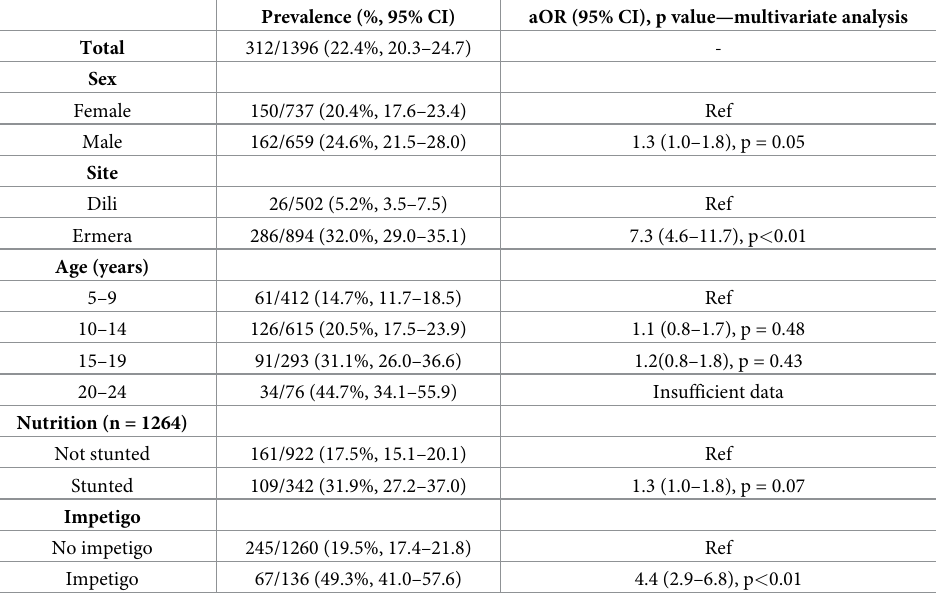
Table 2. Prevalence of scabies and adjusted odds ratio for variables in multivariate analysis.